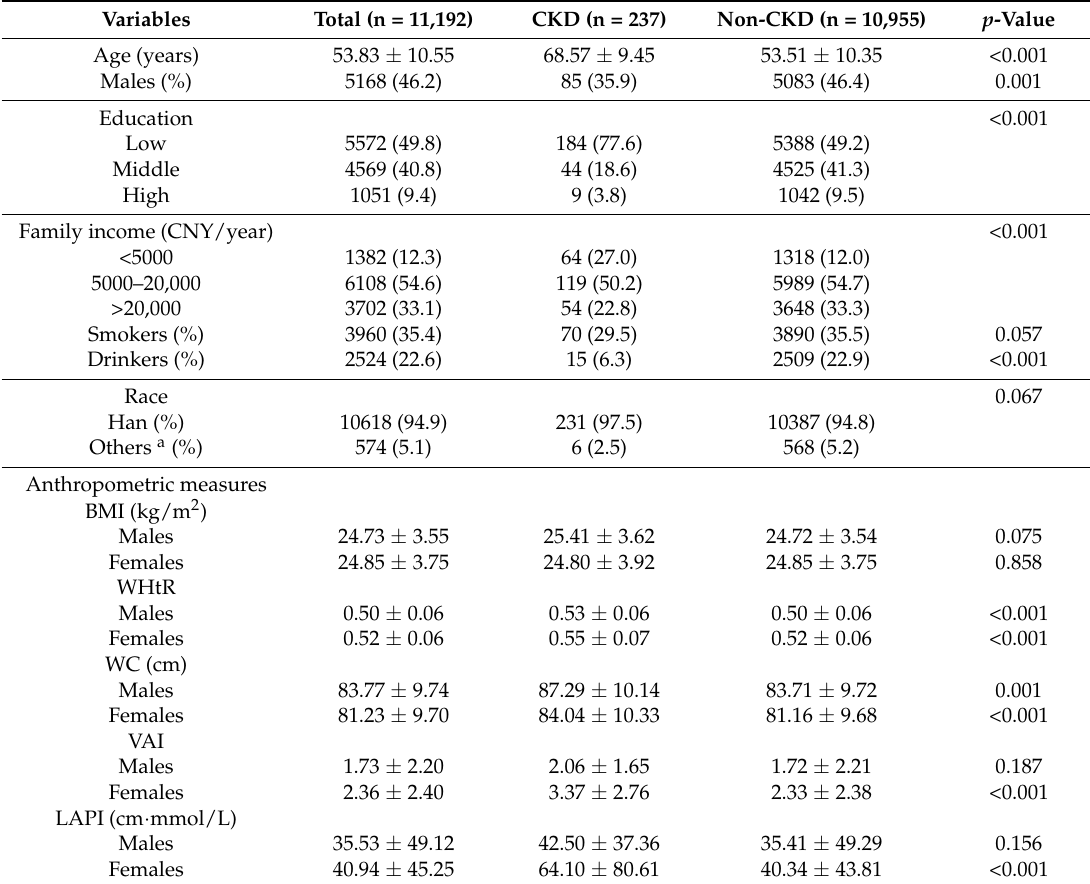
Table 1. Baseline characteristics of the study